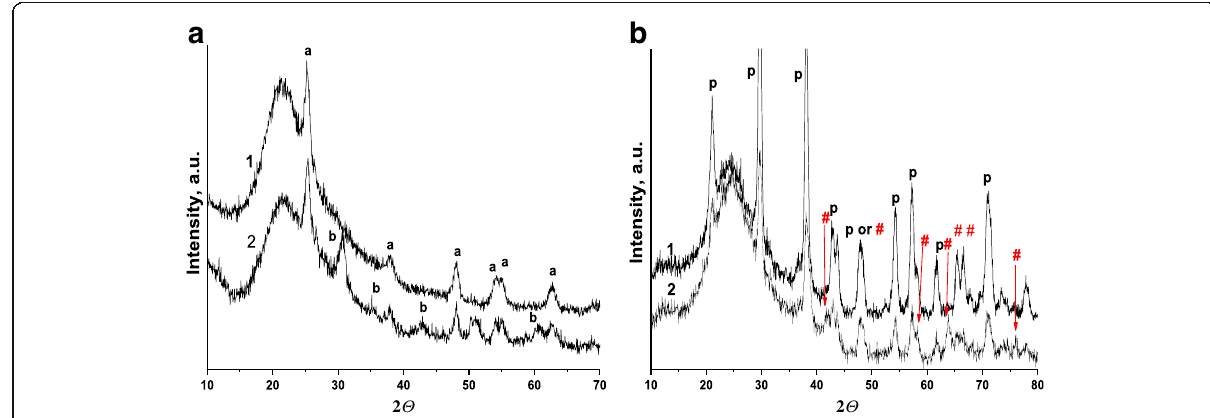
Fig. 3 XRD spectra of the films (450 °C): a TiO 2 ( a , 1 ), N/TiO 2 ( a , 2 ), b Fe x Ti y O z ( b , 1 ); N/Fe x Ti y O z ( b , 2